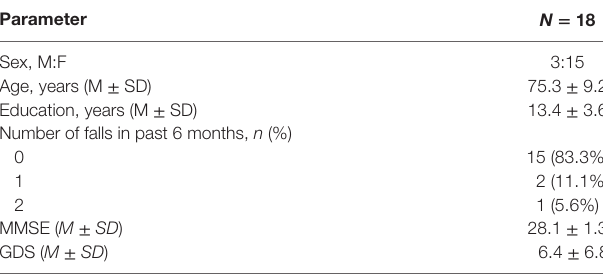
TaBle 1 | Demographic information of